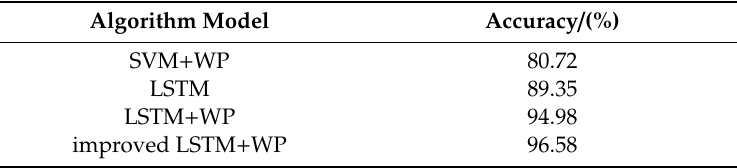
Table 5. Comparison of accuracy between di ff erent